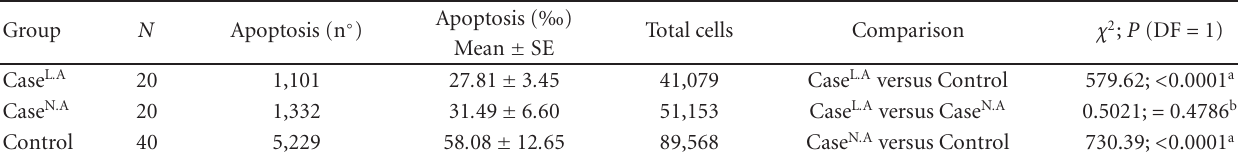
Table 5: Apoptosis analysis ( Σ karyorrhexis, condensed chromatin and